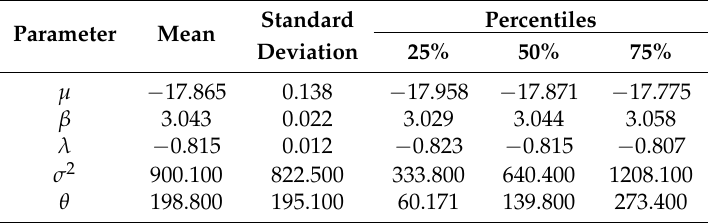
Table 1. Posterior model summary of the hierarchical TLL model parameters.